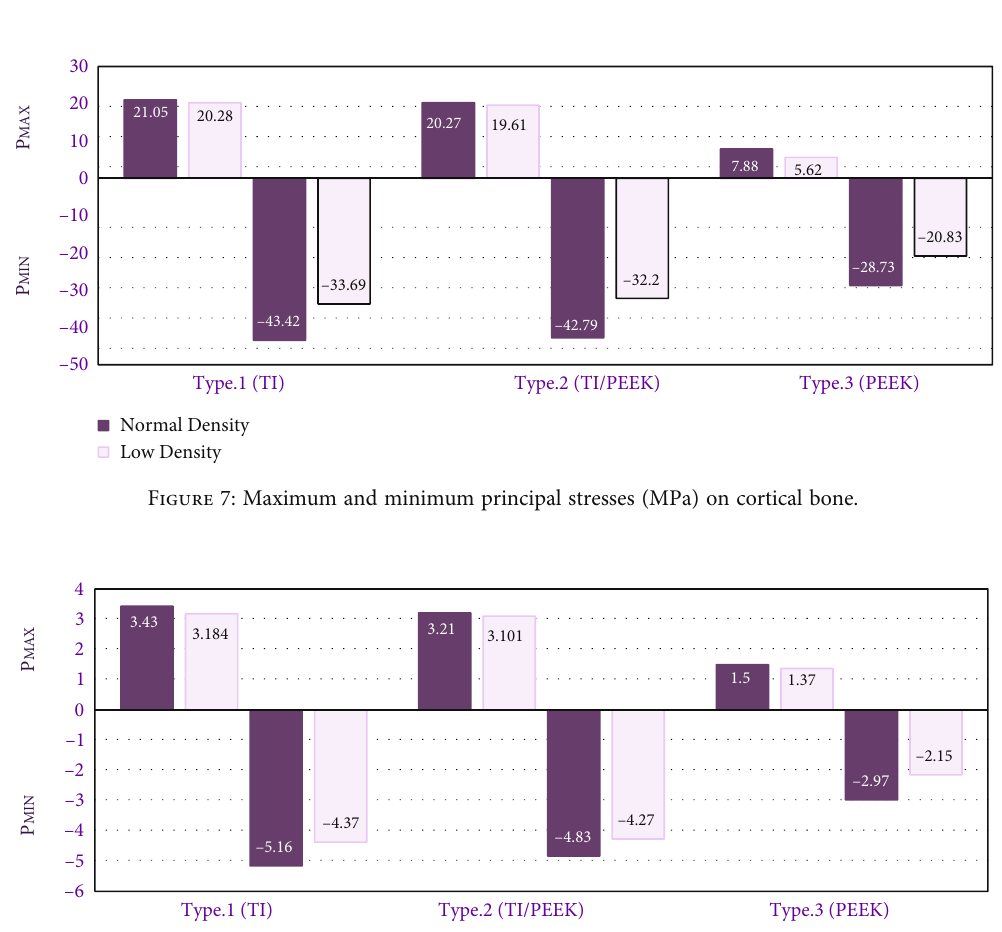
Figure 6: Maximum von Mises stresses (MPa) on mucosa.